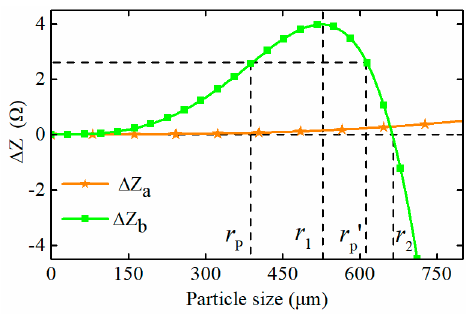
Figure 3. The impedance difference between exciting circuits of different sensors.